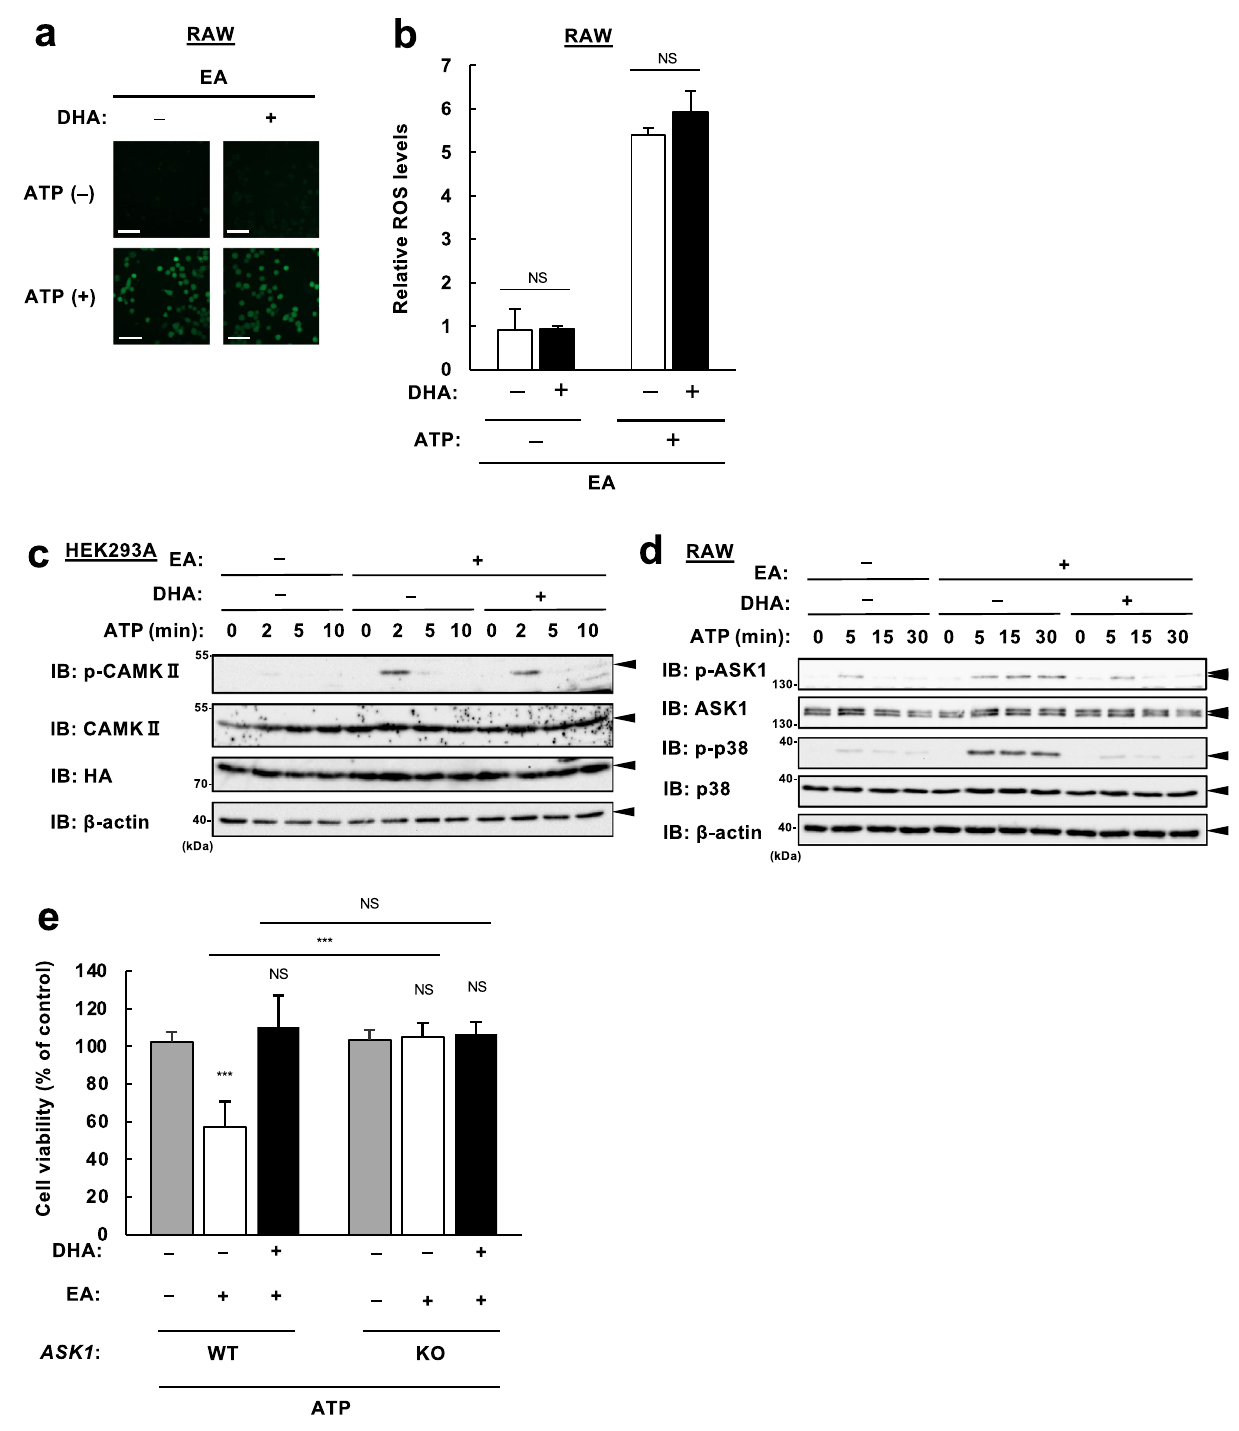
Figure 5. DHA prevents EA-dependent hyperactivation of the ASK1-p38 MAP kinase pathway. ( a , b ) RAW264.7 cells were pretreated with or without 200 µM EA and 50 µM DHA for 12 h. After incubation with 10 µM DCFH-DA for 30 min, cells were stimulated with 0.5 mM ATP for 5 min, and intracellular ROS was visualized by a confocal microscopy ( a ). ROS levels were measured and shown as mean ± SD (n = 3) ( b ). Scale bar, 100 µm. NS, not significant. ( c ) HEK293A cells were transfected with CaMKII and HA-P2X 7 for 12 h, pretreated with the indicated fatty acids for 12 h, and stimulated with 3 mM ATP for the indicated times. Cell lysates were subjected to immunoblotting with the indicated antibodies. ( d ) RAW264.7 cells were pretreated with or without 200 µM EA and 50 µM DHA for 12 h, treated with 0.5 mM ATP for the indicated time periods, and then subjected to immunoblotting with the indicated antibodies. ( e ) Wild-type (WT) and ASK1 knockout (KO) RAW264.7 cells were pretreated with or without 200 µM EA and 50 µM DHA for 12 h, stimulated with 0.5 mM ATP for 6 h, and assayed for cell viability. Data shown are the mean ± SD (n = 3). ***p < 0.001; NS, not significant. Quantifications of immunoblots are shown in Supplementary Fig. S5. Original blots are presented in Supplementary Fig.